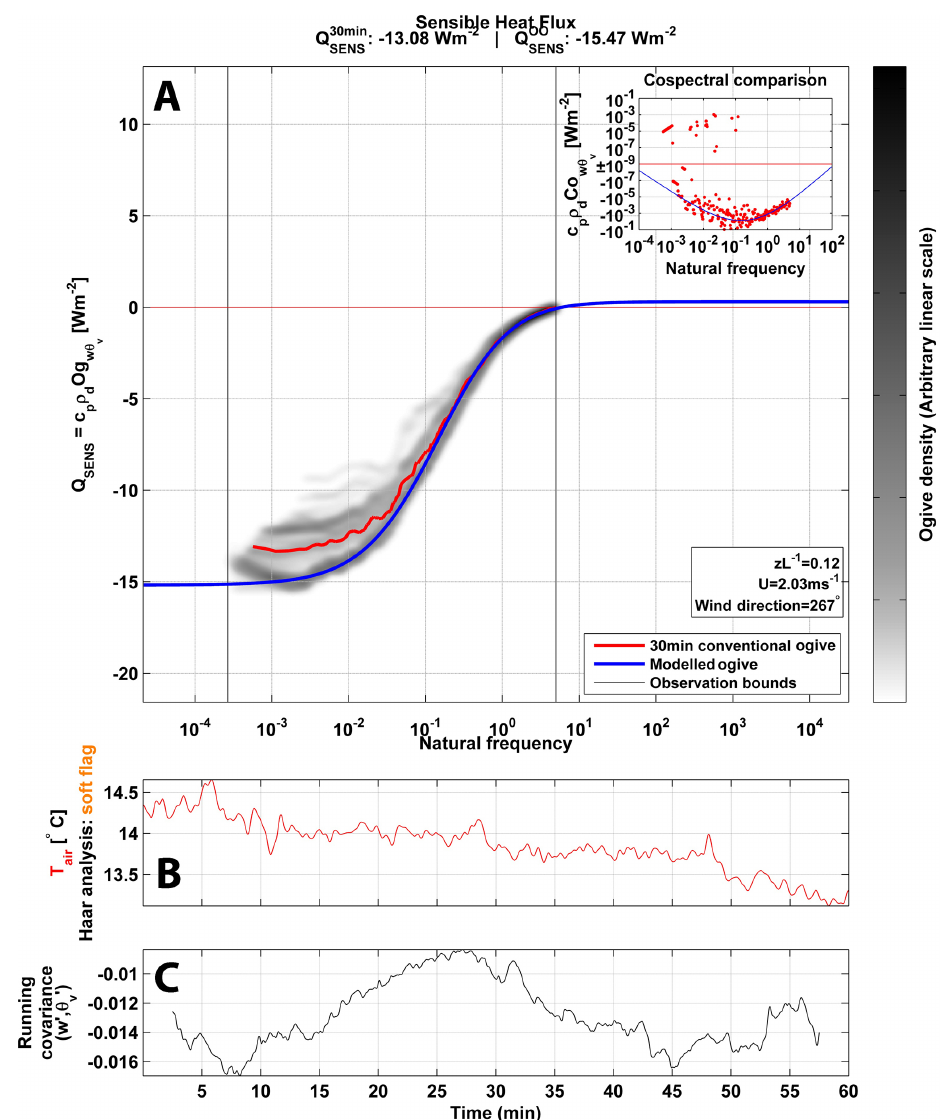
Figure 7. 60min observation of sensible heat flux recorded at Abisko on 10 July 2012 at 8:50p.m. LT. The illustration is similar to Fig.